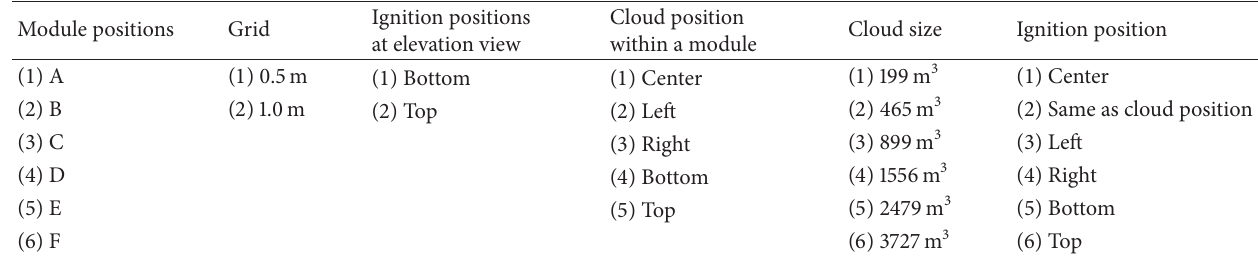
Table 1: The scenarios for vapour cloud